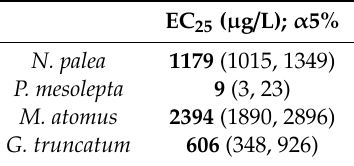
Table 1. Mean EC 25 ( µ g / L, confidence intervals α 5%) e ff ect on quantum yield of PSII for N. palea , P. mesolepta , M. atomus , and G. truncatum after 19 h of exposure to Cd ( n = 3).